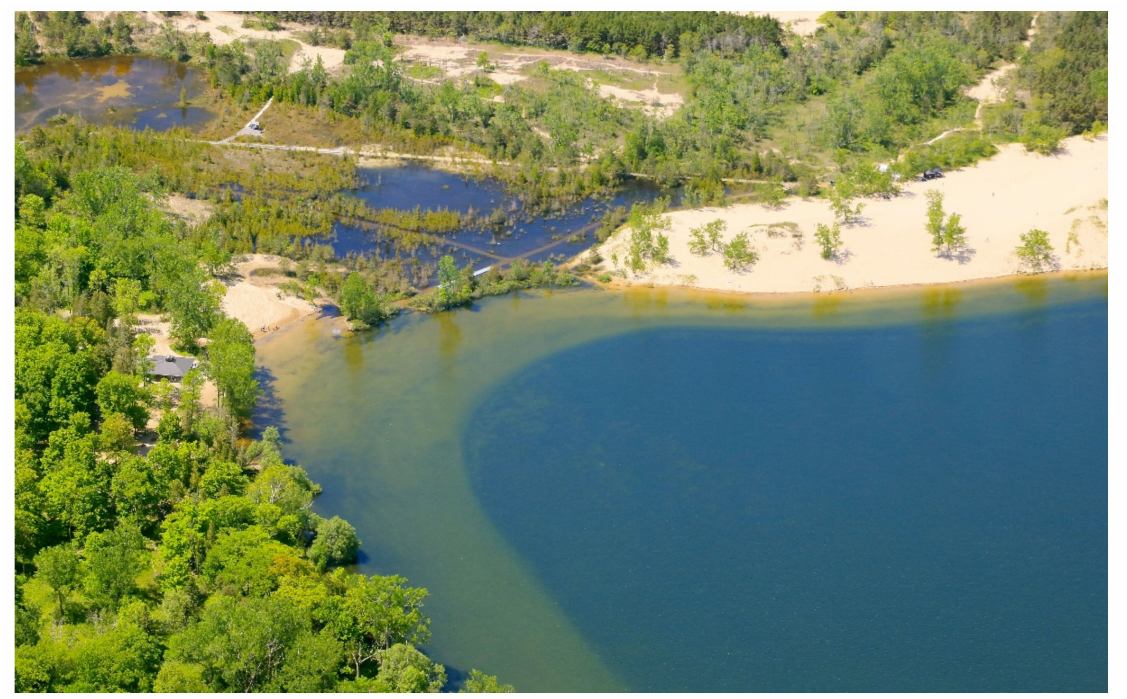
Figure 9. The high water level in West Lake (Aerial image by: John A. Brebner, 2019 © 2019 Friends of Sandbanks Park).